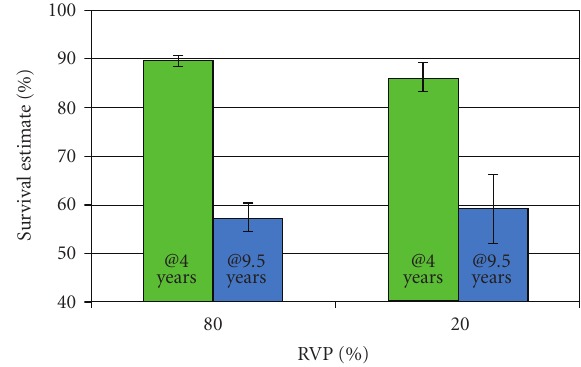
Figure 4: Survival outcomes at 4 years and 9.5 years post implant.